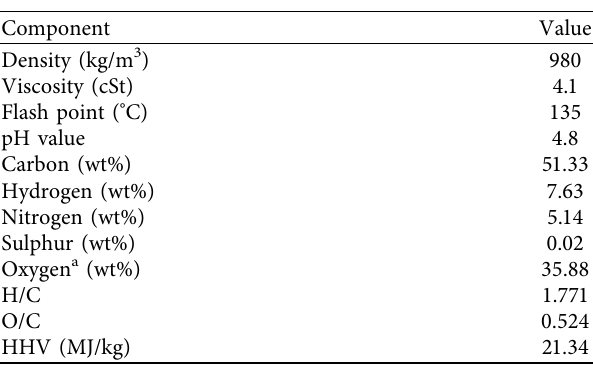
Figure 5: Effect of N 2 flow rate on pyrolysis product Table 5: Properties of the liquid.